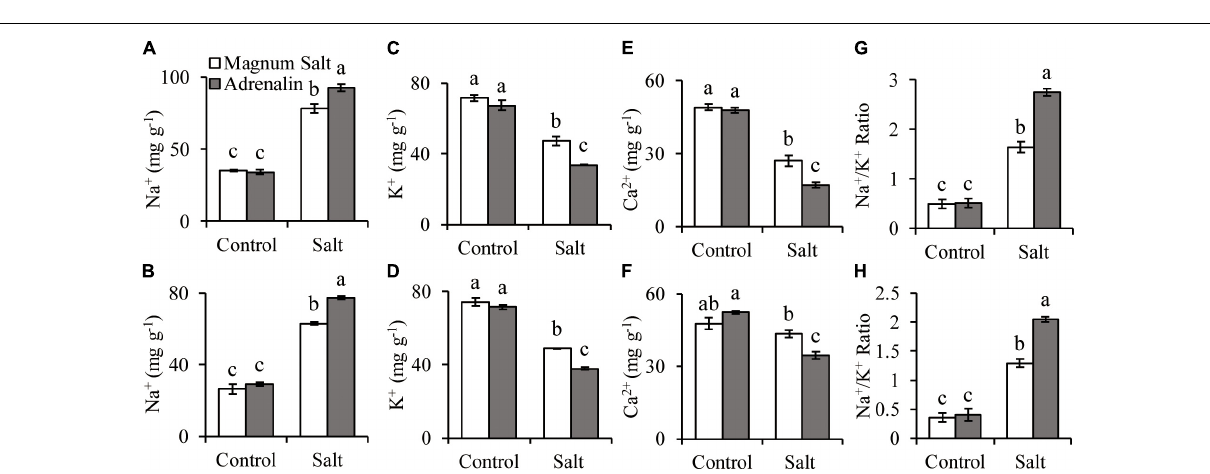
FIGURE 3 | Effect of salt treatment on the Na + , K + and Ca 2 + accumulation in Magnum Salt and Adrenalin. Three-week old seedlings were treated with 1/2 Hoagland solution containing 0 or 150 mM NaCl for 1 week. Na + , K + , Ca 2 + content and Na + /K + ratio in roots (A,C,E,G) and shoots (B,D,F,H) were analyzed. Values are mean ± SE ( n = 3 replicates). Different letters indicate the significant differences ( P < 0.05, LSD) between two cultivars or